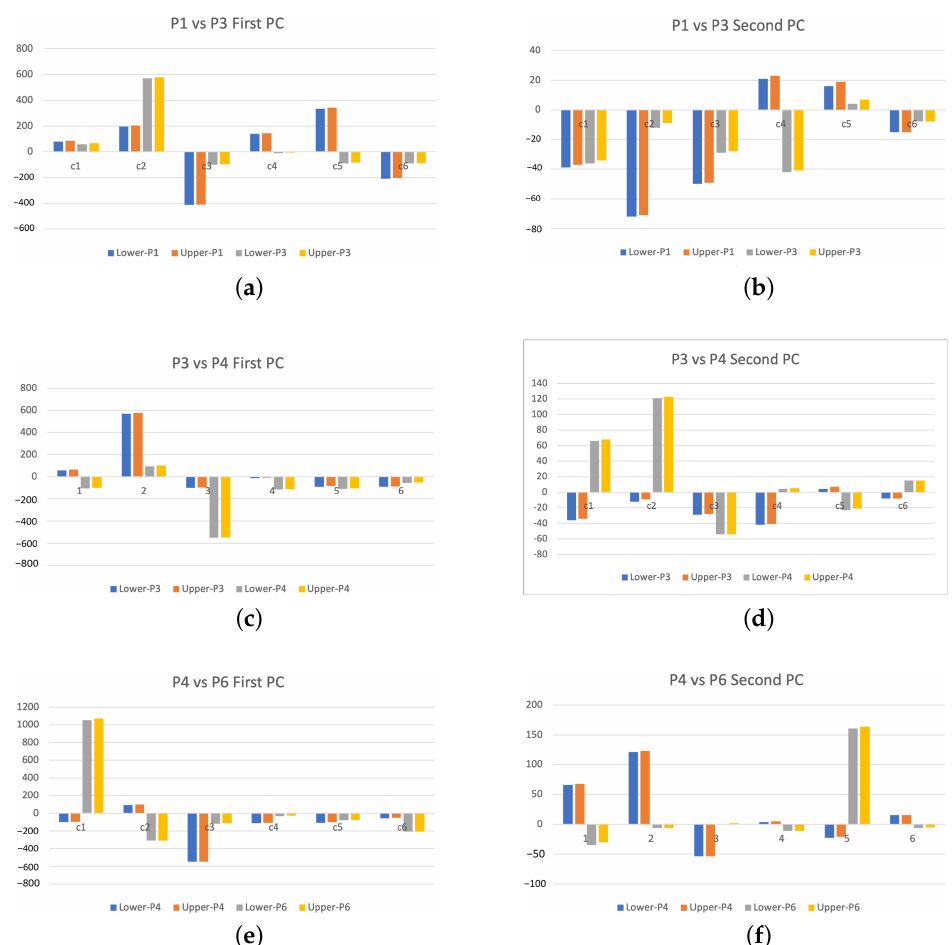
Figure 9. The pairwise comparisons of lower and upper 95% confidence limits of extracted first and second principal component scores of DWT power spectra for all channels (i.e., c1, c2, c3, c4, c5, and c6) for patients at the interitcal stage. ( a ) Patient 1 vs. Patient 3, 1st PC, ( b ) Patient 1 vs. Patient 3,